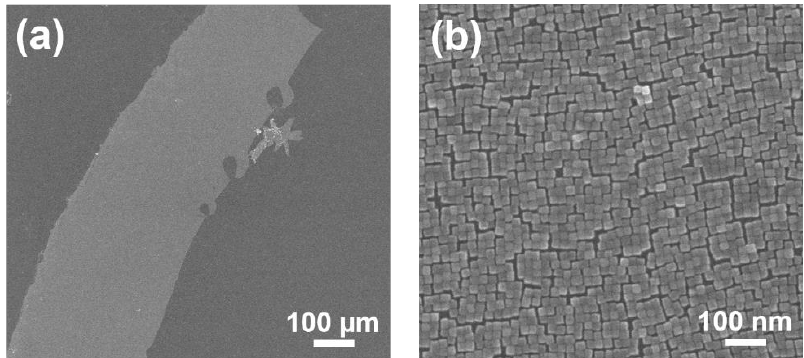
Figure 2. Scanning electron microscope (SEM) images of BT nanocube monolayer transferred on a silicon substrate. ( a ) Entire image and ( b ) magnified image of the monolayer.